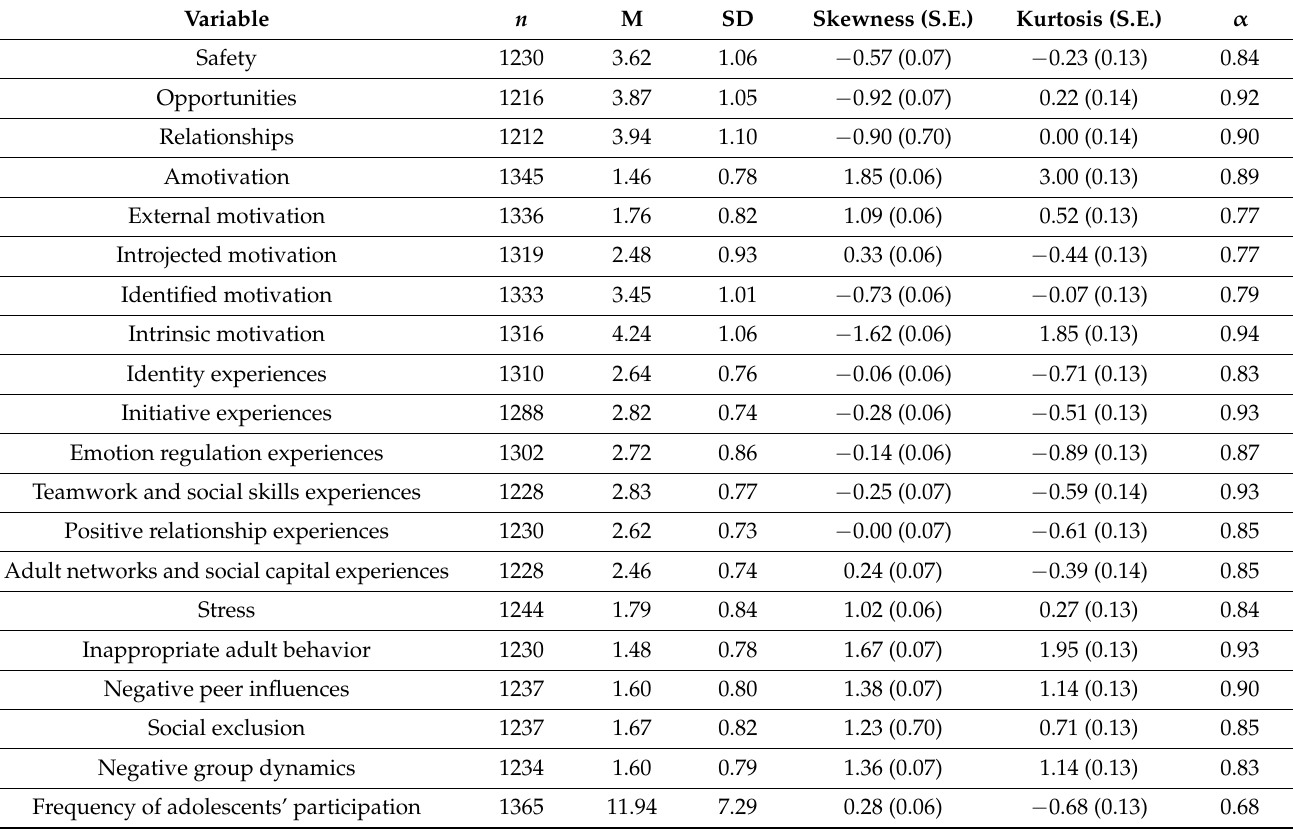
Table 3. Descriptive statistics of study